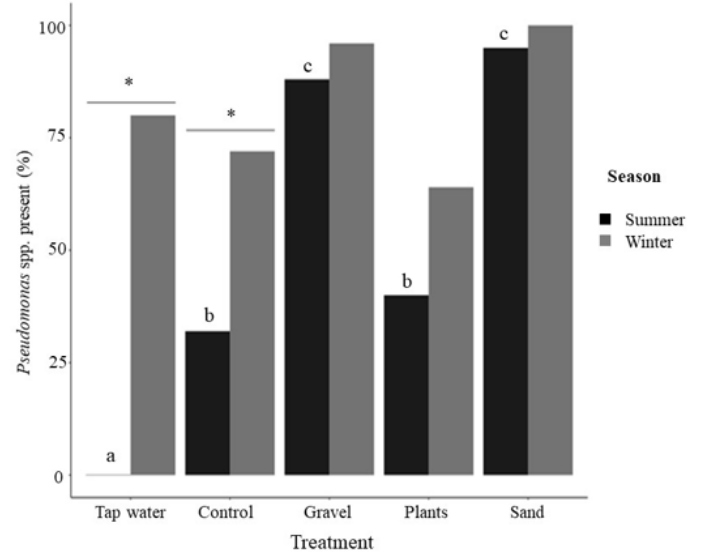
Figure 7. Presence of Pseudomonas in tanks. Percent of positive Pseudomonas spp. samples by enrichment treatment and season. Asterisks indicate significance between seasons within a treatment (post-hoc Tukey p < 0.05). Different letters indicate significance between enrichment treatments within a season (post-hoc Tukey p < 0.05). Data are means ±SEM, tap water: n = 7; for control, gravel, plants, sand, n = 35 (i.e., 5 tanks × 7 weeks with data combined across time).